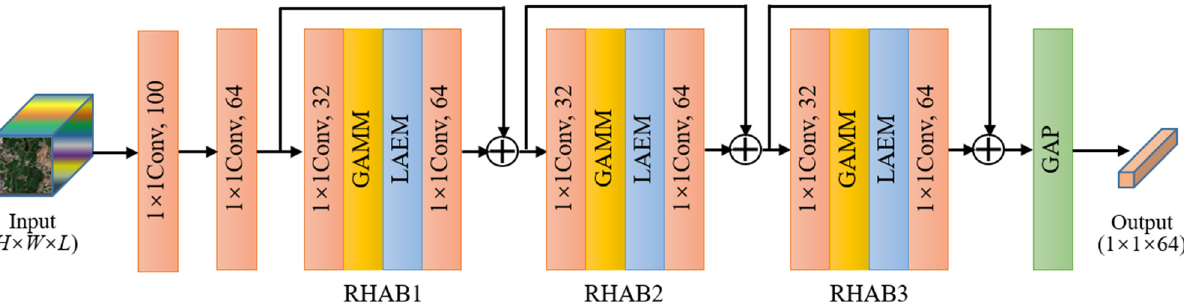
Figure 5. The architecture of feature extractor DRHAN. For convenience, batch normalization and reflect linear units following convolutional layers are not presented.